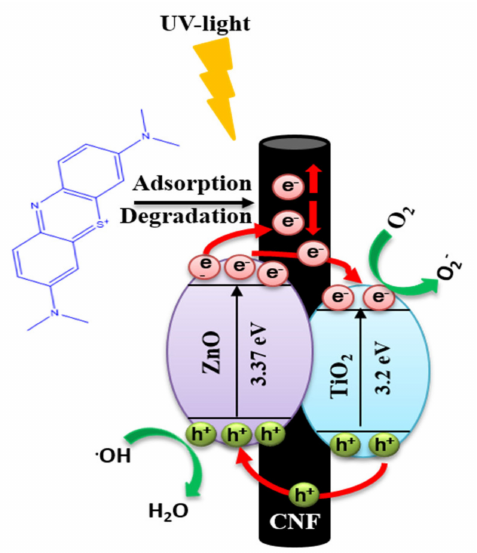
Figure 6. Proposed mechanism of photocatalysis by the as-prepared ZnO-TiO 2 -CNFs composite photocatalyst.